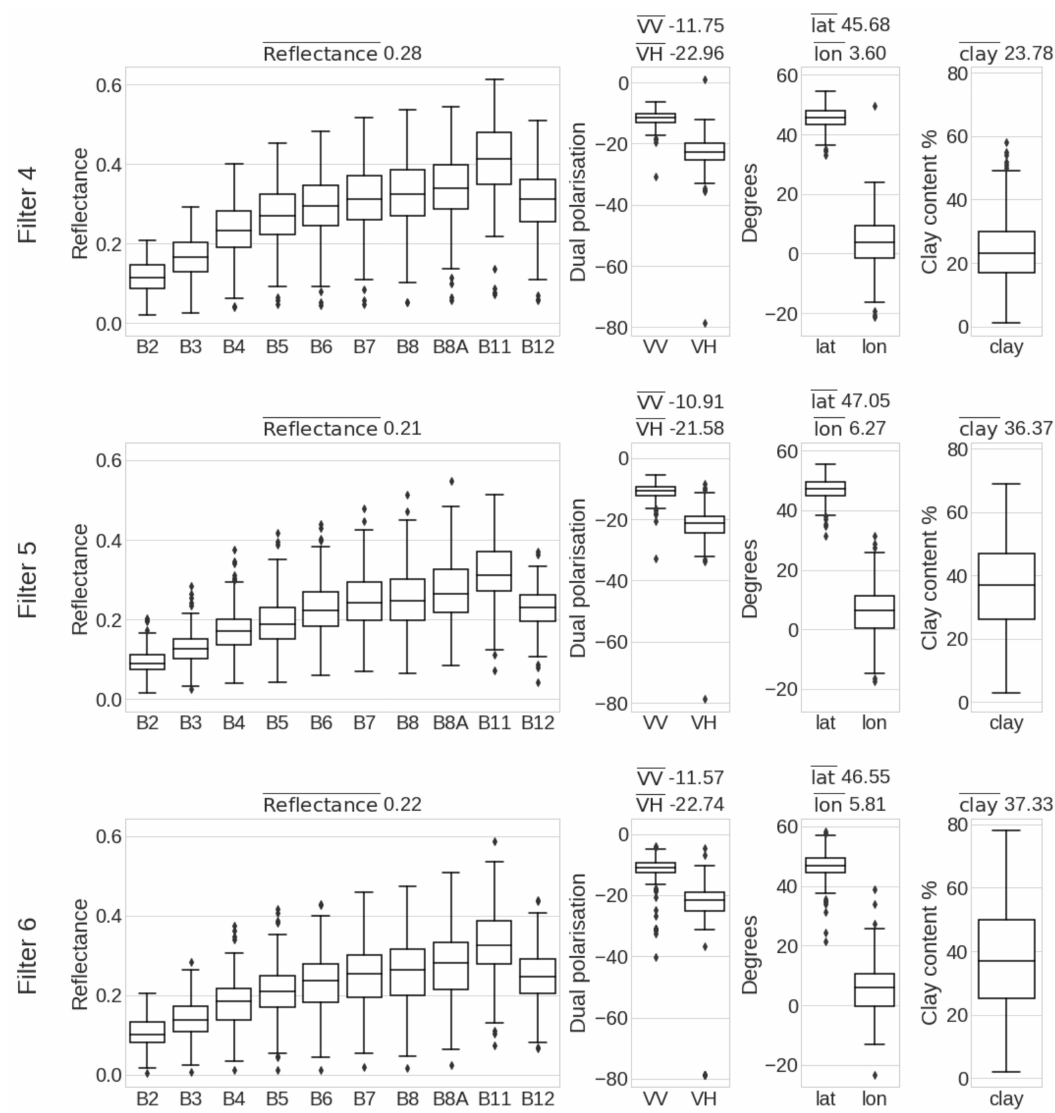
Figure 11. Visualization of the top 5% of activated patterns from the training set for the other three selected filters from the final convolutional layer. x is the arithmetic mean of x